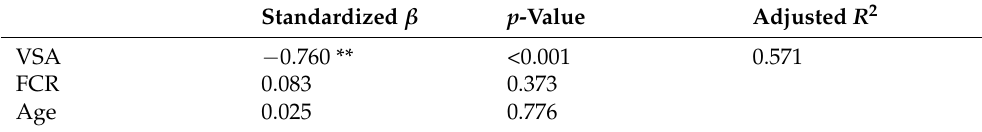
Table 3. Multiple linear regression analysis of factors correlated with the VDS.